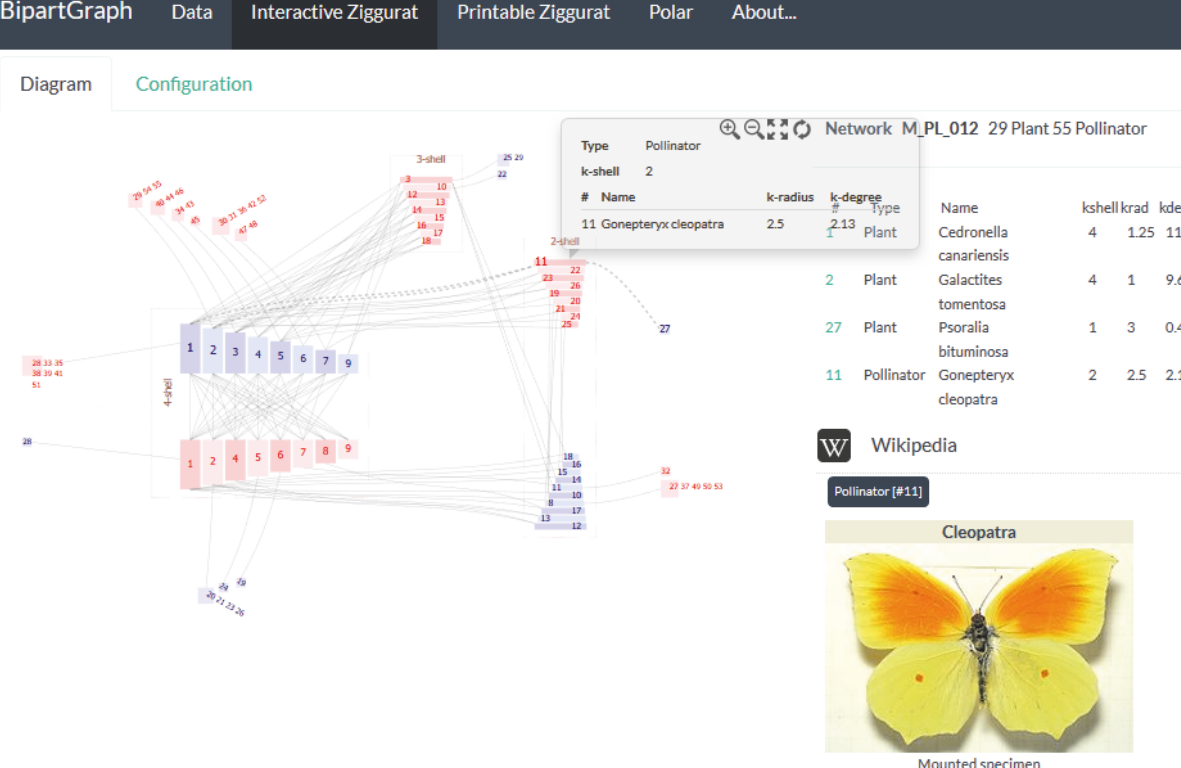
Figure8:Interactivezigguratuserinterface.Plant-pollinatorassemblyinGarajonay,CanaryIslands(Spain),recordedbyOlesen,highlighting the pollinator species number 11, Gonepteryx cleopatra